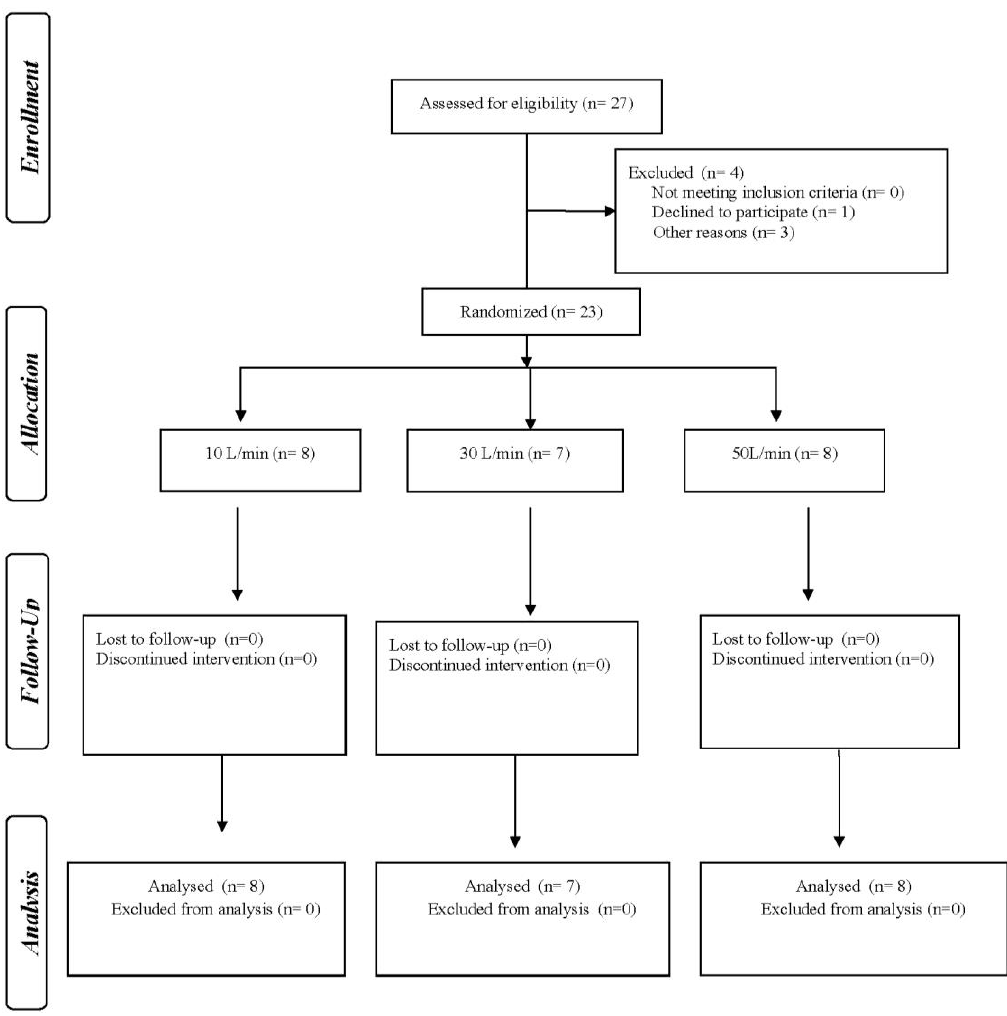
Figure 1. Study flow chart.